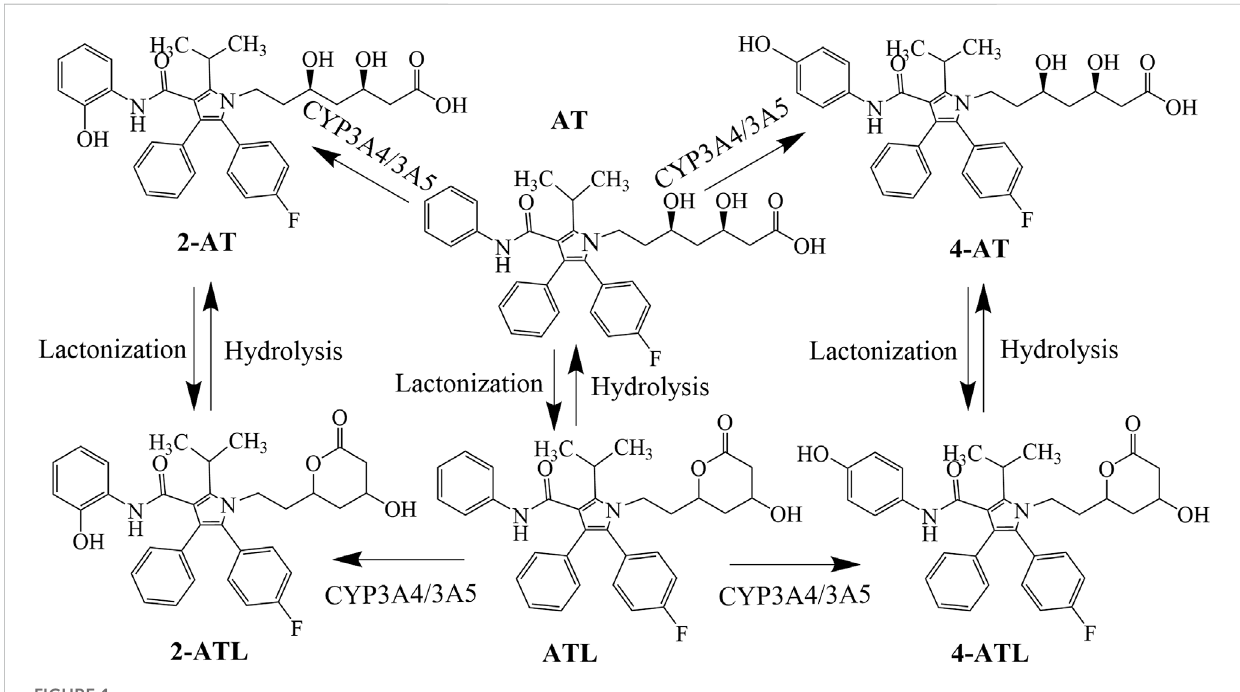
FIGURE 1 Conversion processes of atorvastatin and its